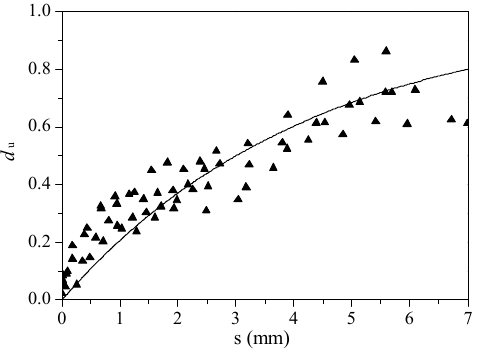
Figure 11. Relationship between damage factor and slip.